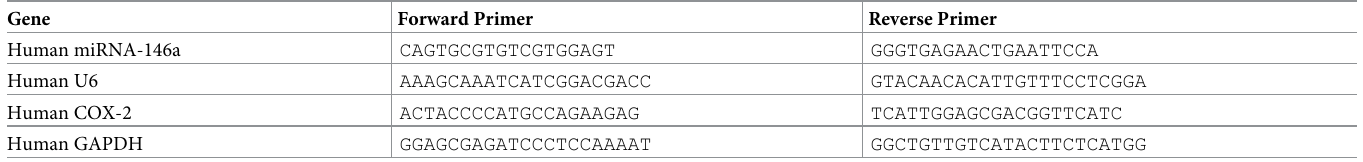
Table 2. Primer Sequences of human miRNA-146a and